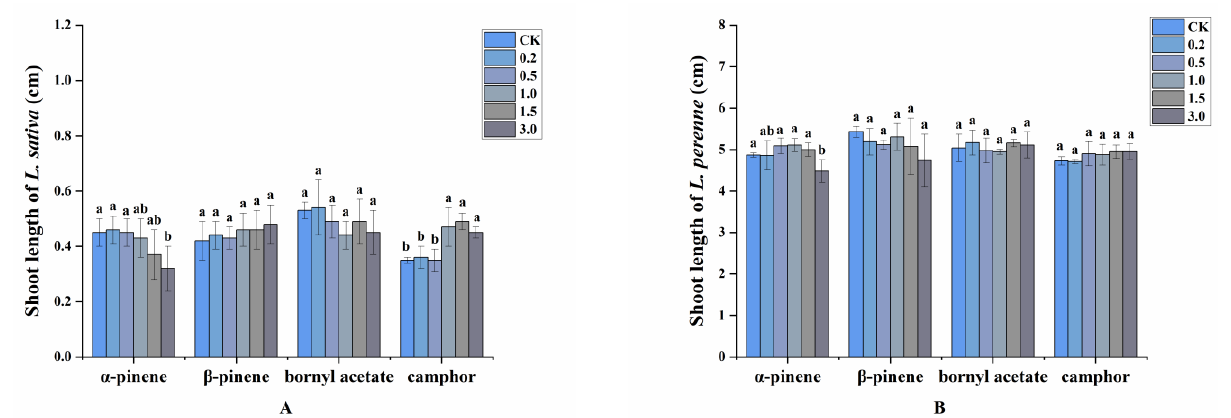
Figure 5. Allelopathic effects of the four main volatile compounds from the oil of A. villosum on the shoot length of ( A ): L. sativa and ( B ): L. perenne . Each value is the mean of five replicates ± SD ( n = 30). Means with different lowercase letters indicate significant differences at p < 0.05 level according to ANOVA and Fisher’s LSD test.